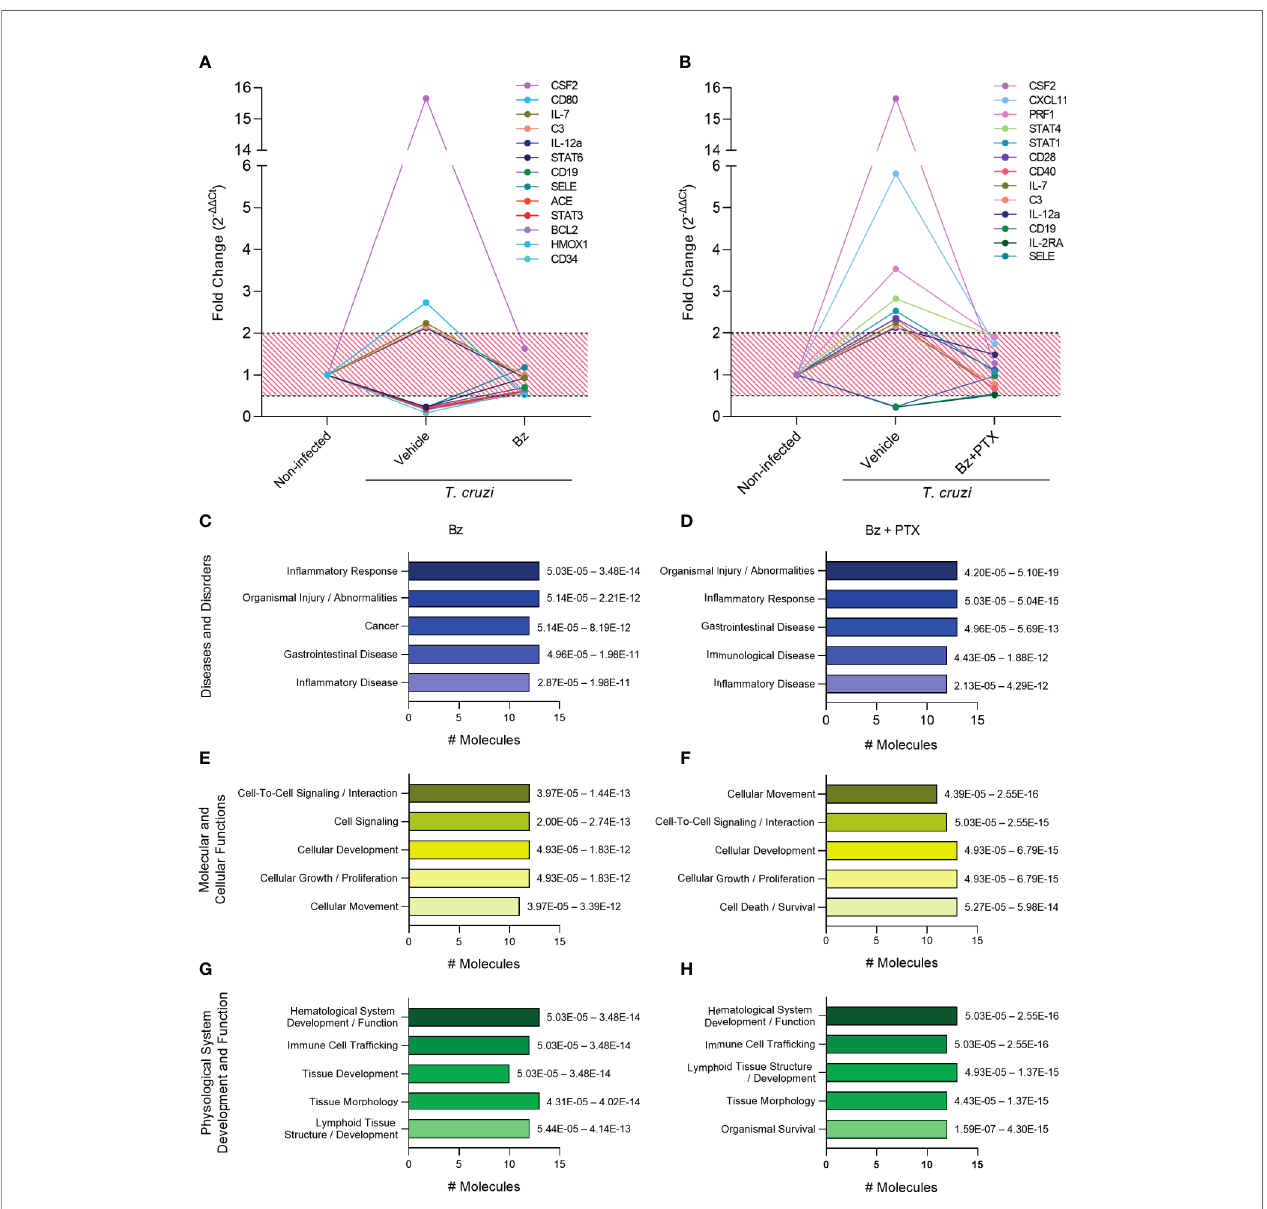
FIGURE 5 | Characterization of immune response expression pro fi le for the Bz and Bz + PTX group. (A) Expression of immune genes increased in the infected group and with restored expression with Bz therapy or (B) Bz+PTX therapy. Relative expression was expressed as fold change (2 - DD Ct ). Genes with values under 0.5 and over 2 in the infected group and in between 0.5 and 2 in Bz or Bz+PTX therapies group were considered as restored expression and selected for further analysis on IPA software. The graphs show the activated pathways in the infected group that are regulated with therapy. (C, D) IPA analysis with top signi fi cantly associated to Disease and Disorders to the Bz or Bz+PTX groups, respectively. (E, F) IPA analysis with top signi fi cantly associated to Molecular and Cellular Functions to the Bz or Bz+PTX groups, respectively. (G, H) IPA analysis with top signi fi cantly associated to Physiological System Development and Function to the Bz or Bz+PTX groups, respectively. The signi fi cance interval of enrichment is shown on the right of the